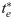
Numerical solutions for optimal control.Optimal control trajectories for different cost functions fi(α(t)) ∈ {α(t), α2(t), α3(t)}. The corresponding optimal terminal times, te*, are determined as {65.99τ, 66.13τ, 66.31τ}. I0 = 0.0025, Ih = 0.01, R0 = 3, S(te*)=R0−1. R∞ is the asymptotic reproduction number for t → ∞, given by R∞ = −W(exp(−1 − R0
Ih)), with the Lambert W function.